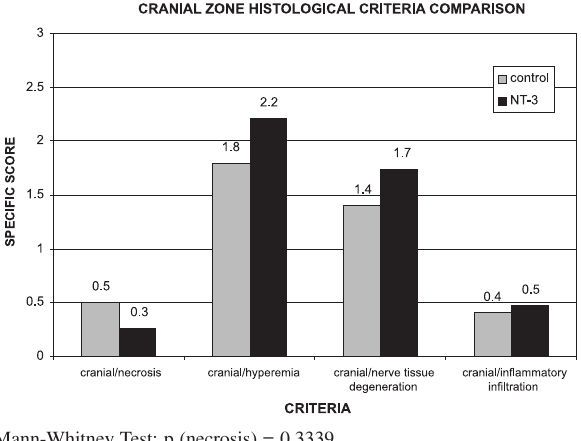
Mann-Whitney Test: p (necrosis) = 0.3339. Figure 5 - Comparison of Specific Scores in the Cranial Zone between Control and NT-3 Groups